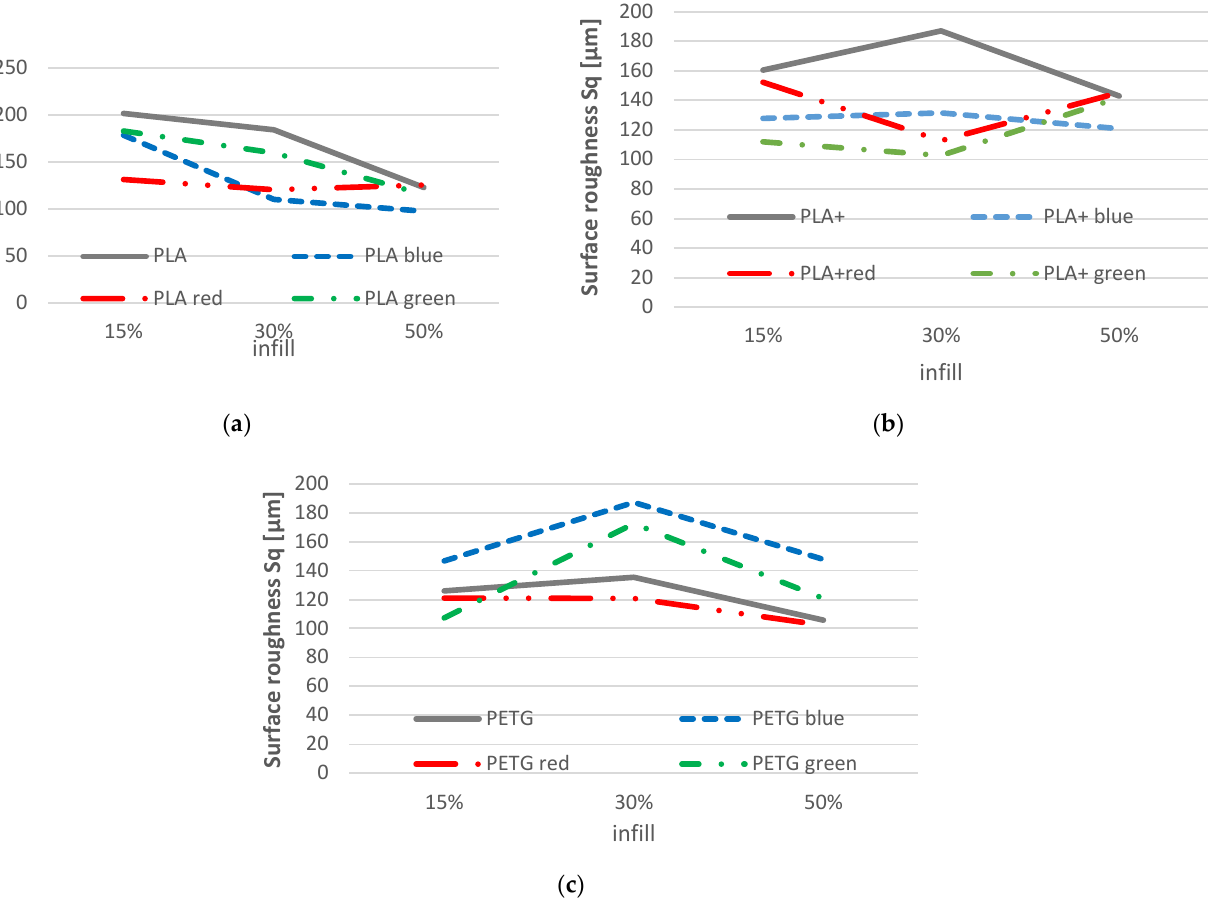
Figure 17. Comparison of surface roughness between coloured and uncoloured printed parts: ( a ) PLA material; ( b ) PLA+ material; ( c ) PETG material.